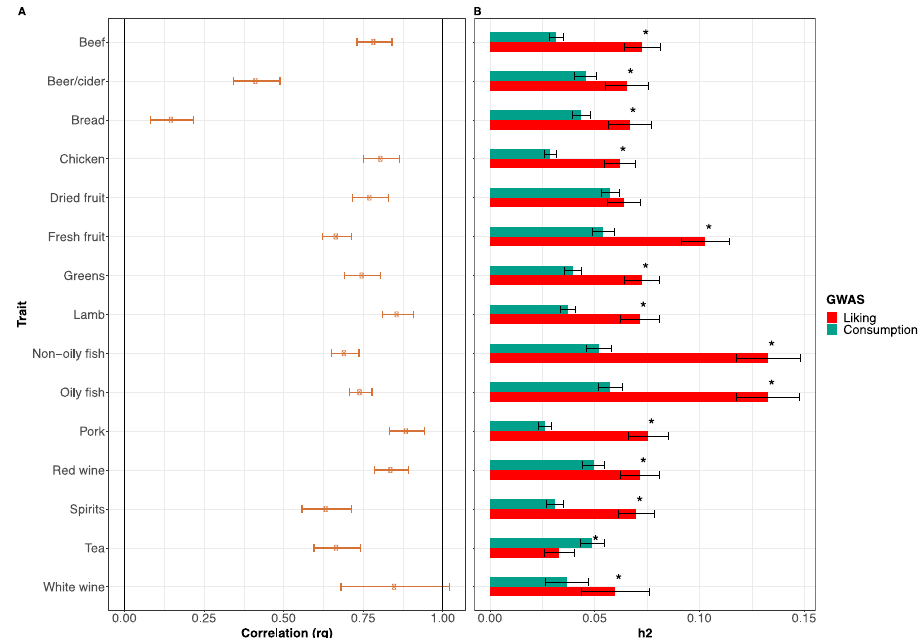
Fig. 2 Genetic comparison between food-liking and food-consumption traits. Panel A reports the genetic correlations between consumption and liking of the same food for those foods for which both measurements were available, bars represent 95% CI. Panel B displays a comparison between SNP heritability of food consumption (green) and liking (red). Bonferroni-corrected signi fi cant differences are indicated with a star. Bars represent 95%